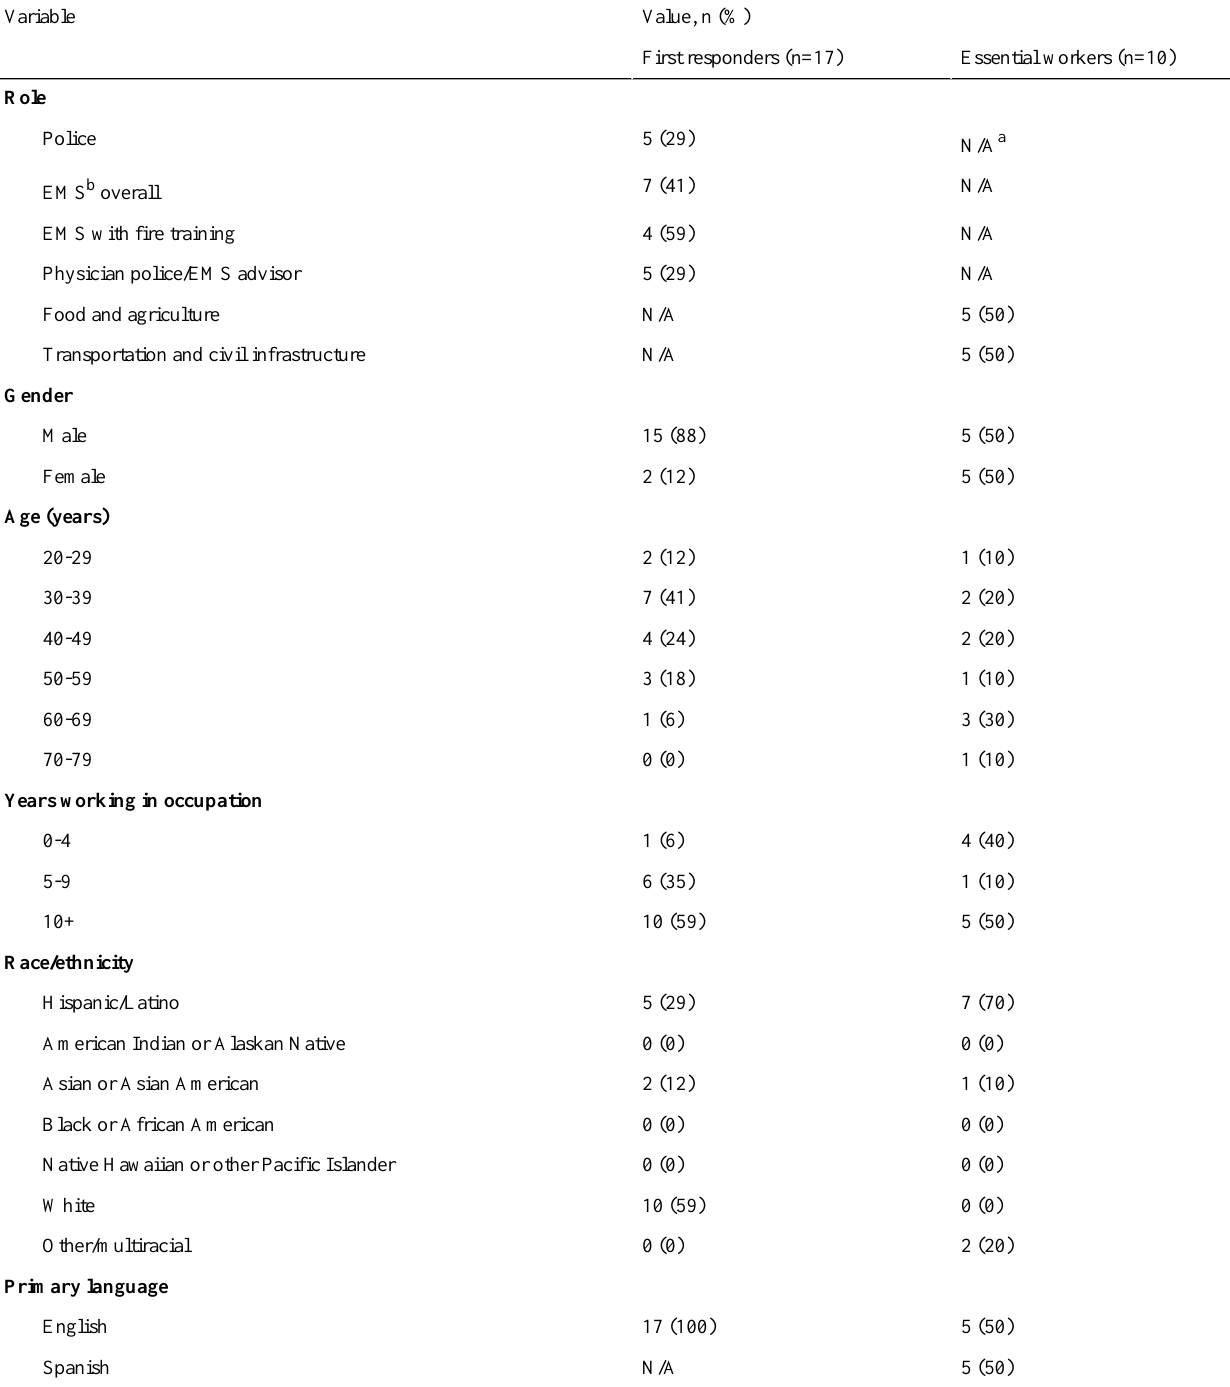
Table 1. Participant demographics of the first responders and essential workers